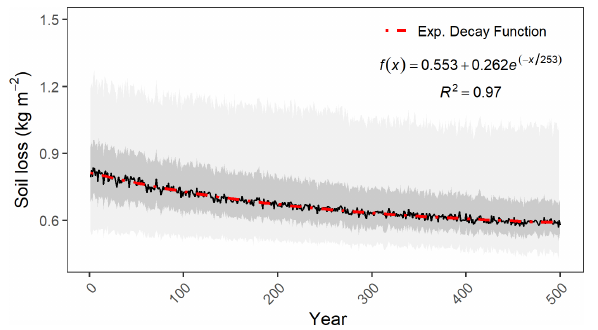
Figure 5. Soil erosion trends over 500 years of model simulations for the profiles from the UK SOILPITS dataset. The dark solid line represents the median of all profiles and simulations, whereas the dark- and light-grey shaded areas are 50% and 95% prediction in- tervals, respectively.